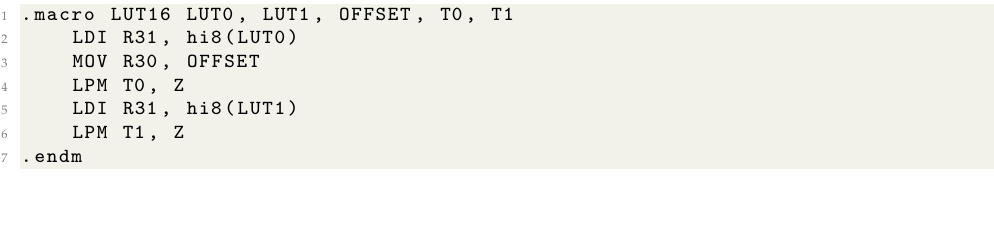
Algorithm 5: Proposed PRESENT-CTR16